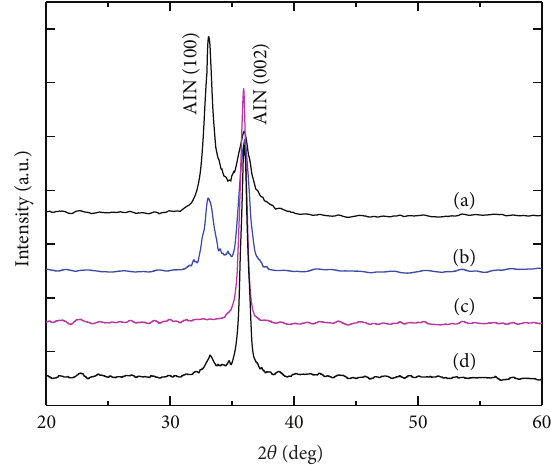
F 1: e XRD patterns for AlN �lms prepared at laser energy density of (a)